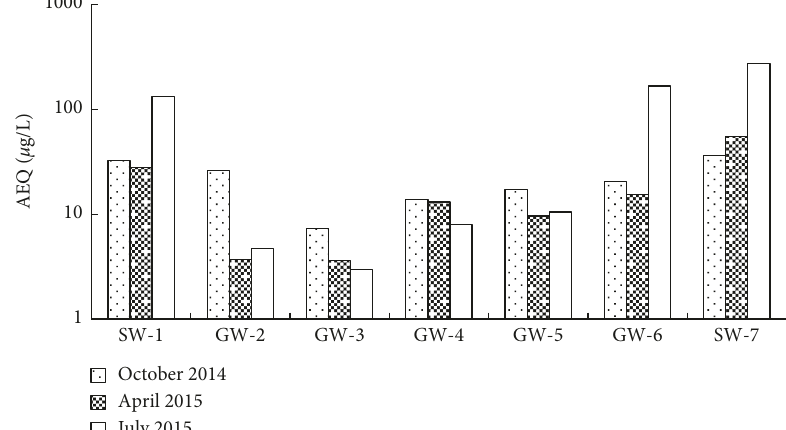
Figure 4: Thyroid-disrupting potency of water samples collected from the riverbank filtration system in Wuchang City, China. AEQ: amiodarone hydrochloride equivalent level.